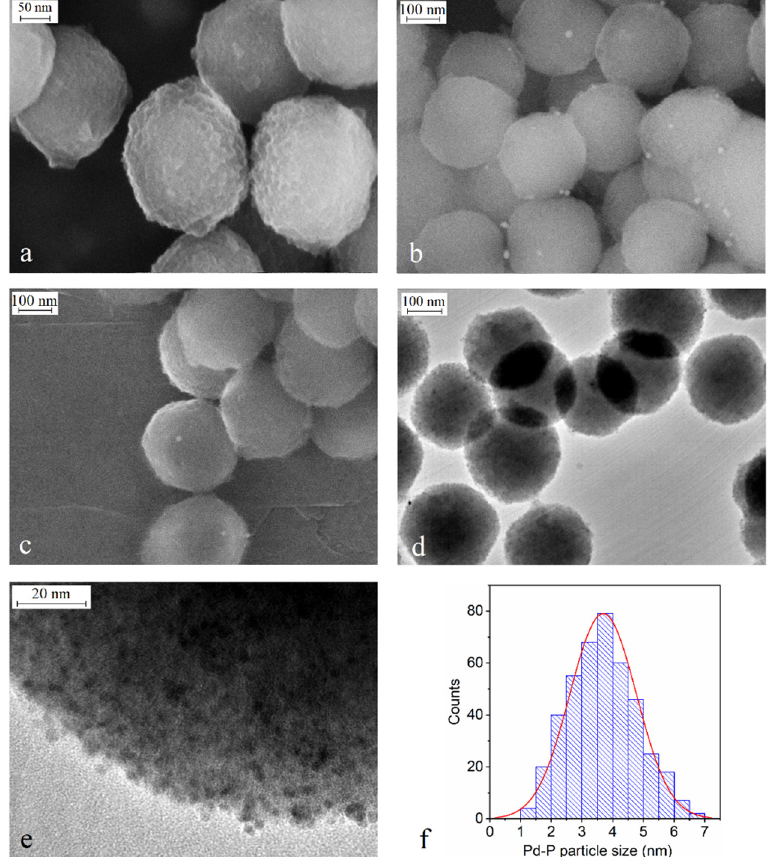
Figure 2. Electron microscopy of SiO 2 , Pd ◦ /NH 2 -SiO 2 and Pd-P/NH 2 -SiO 2 : ( a ) SEM image of SiO 2 , ( b ) SEM image of Pd ◦ /NH 2 -SiO 2 , ( c ) SEM image of Pd-P/NH 2 -SiO 2 , ( d ) Transmission electron microscopy (TEM) image of Pd-P/NH 2 -SiO 2 , ( e ) enlarged TEM image of Pd-P/NH 2 -SiO 2 , ( f ) Pd-P particle size distribution calculated for 400 particles.